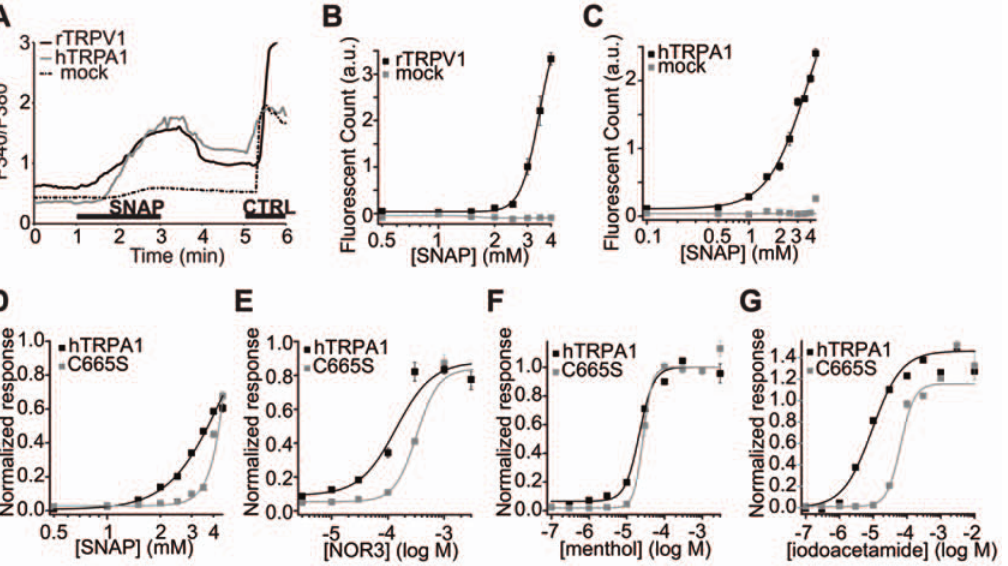
Figure 2. NO donors induce calcium influx in cells expressing TRPV1 or TRPA1. (A) SNAP (2 mM) increases intracellular calcium (F340/F380) in rTRPV1- and hTRPA1-expressing CHO cells (black and grey lines, respectively) but not YFP-positive mock transfected CHO cells (dashed